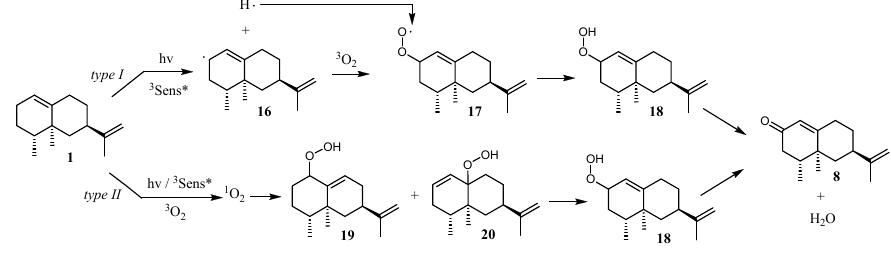
Figure 6. Proposed photooxidation mechanisms of valencene ( 1 ) to obtain nootkatone ( 8 ). In the absence of light, the yield decreased (Table 2, entry 2 and 4) although with minor nootkatone formation. We assume the radical chain oxidation process does not